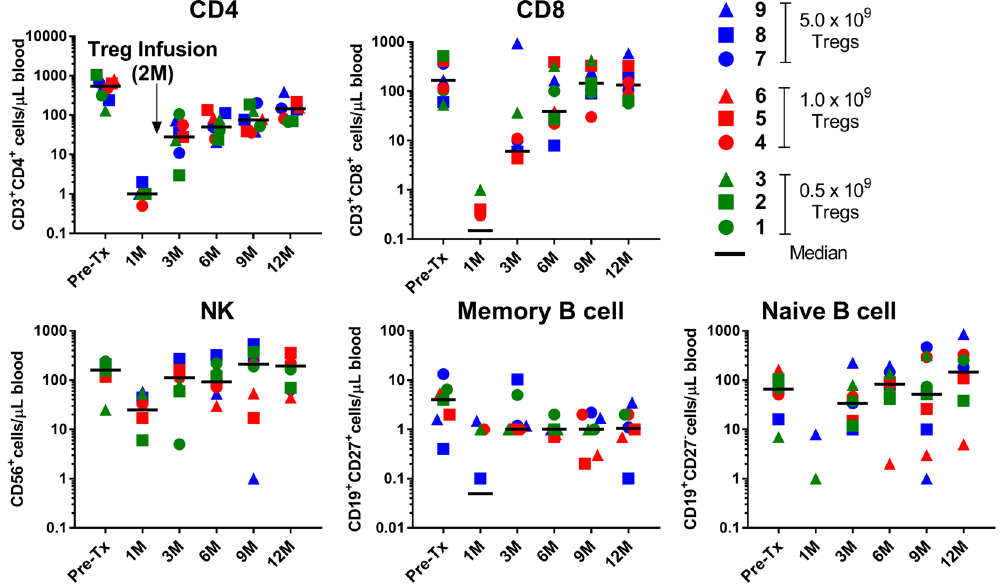
Figure 4. Immune monitoring of recipients post Alemtuzumab induction and Treg infusion. Absolute cell numbers (symbols) and grand median (- line) of T, B, and NK, Tregs per uL of blood from pre-transplant to 12 months post-transplant in all nine recipients (n = 9). Note: Alemtuzumab was given on day 0 and 2 of transplant, and Tregs were infused at two months